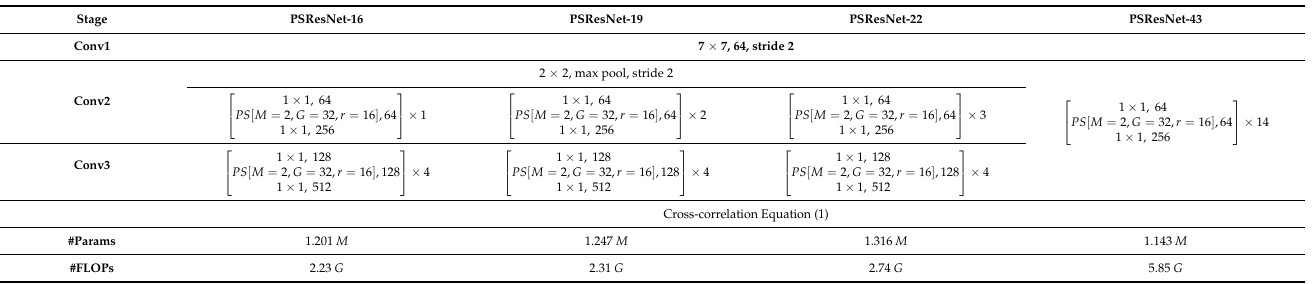
Table 1. Full architectures of the designed backbone networks for Siamese trackers. G denotes the grouped convolution. M denotes the number of